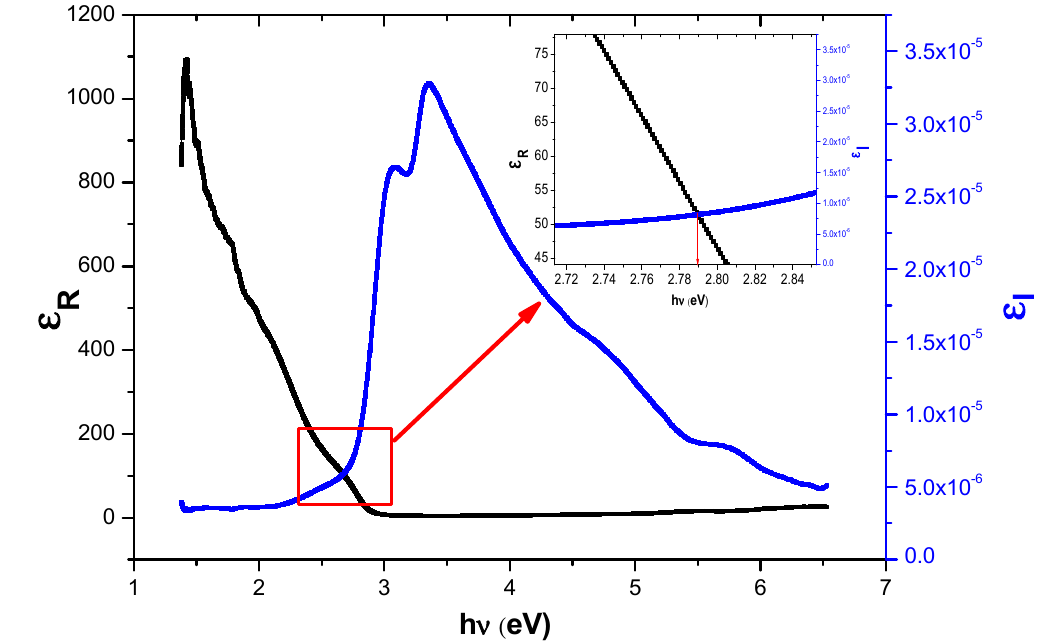
Figure 4. Dependence of the real and imaginary parts of the dielectric constant as a function of the energy.